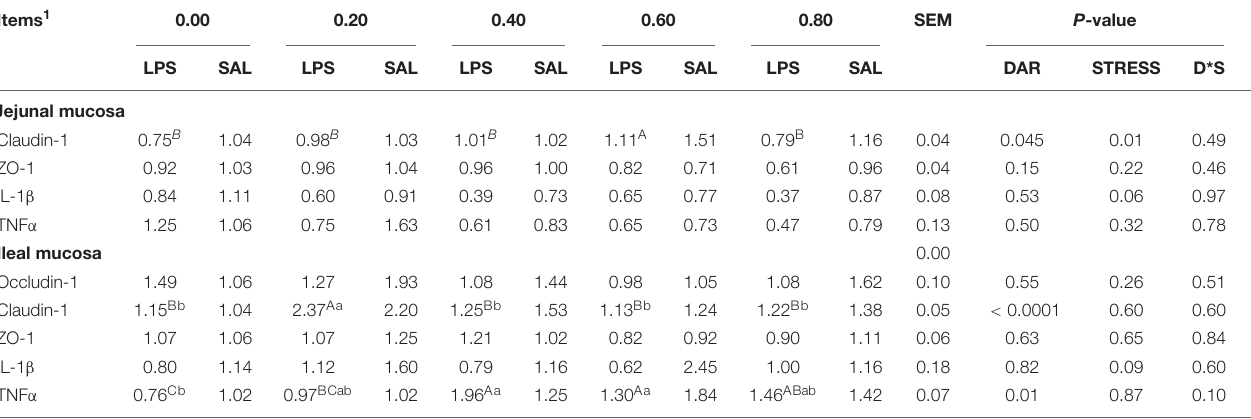
TABLE 7 | Effect of DAR on gene expression of intestinal mucosa of weaned piglets challenged with E. coli LPS.